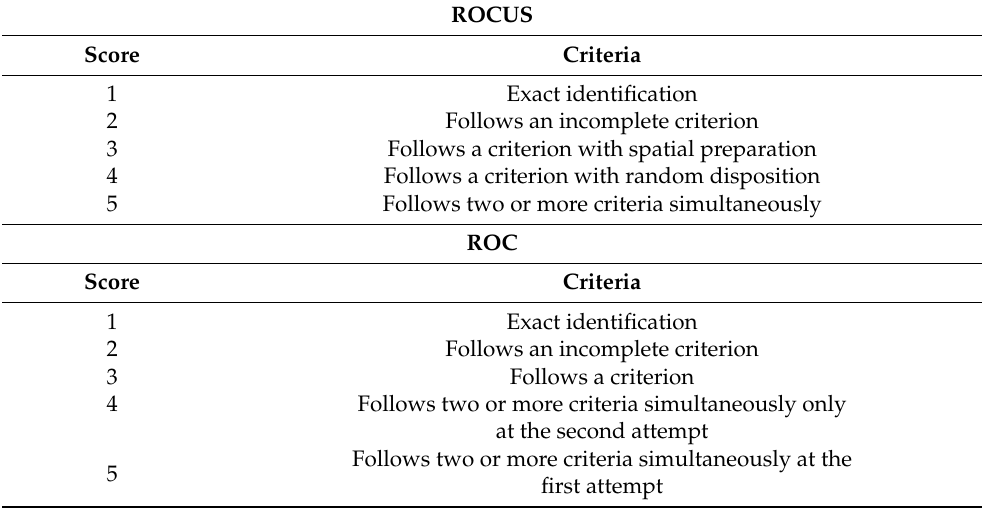
Figure 1. ( a ) ROC-d assessment system distributed user interface; and ( b ) Menu of ROC-d for therapist. Table 2. ROC-d assessment score.